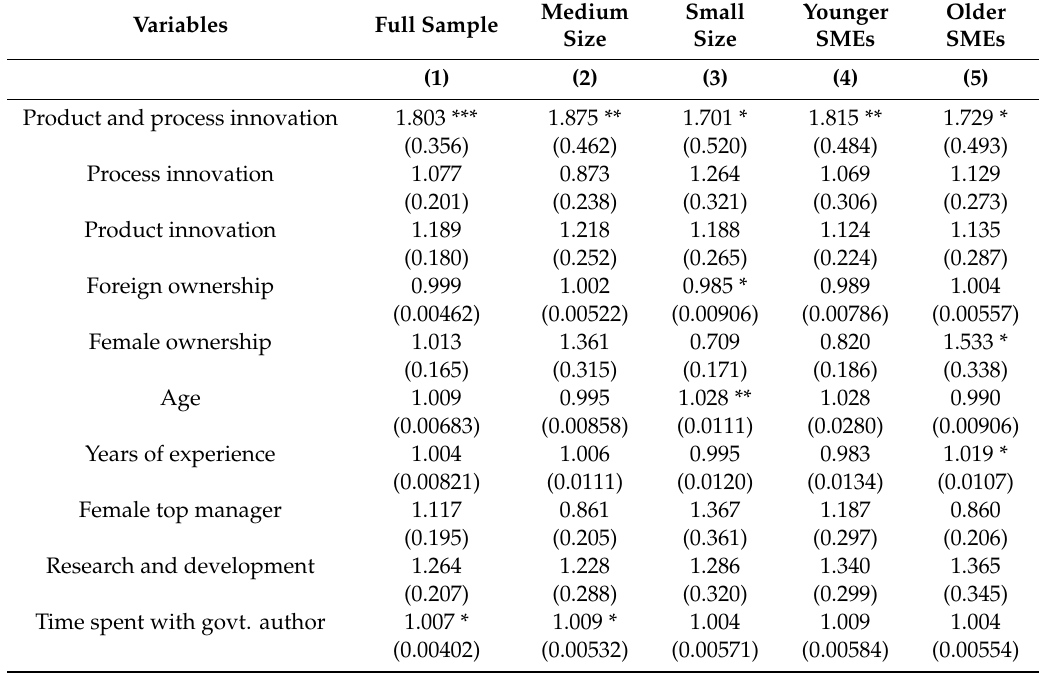
Table 6. Doubly robust logistic regression